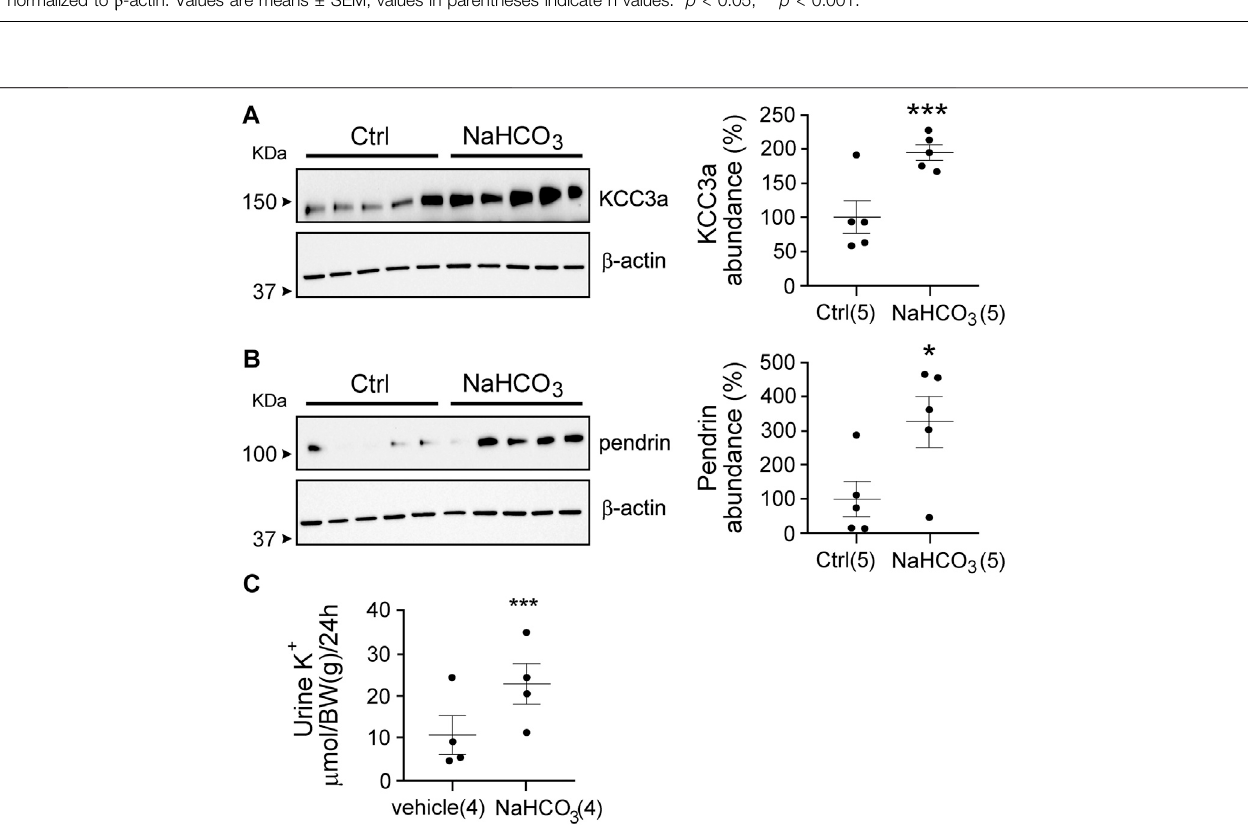
FIGURE7| LinkbetweenpendrinandKCC3a. (A,B) NaHCO 3 treatmentfor24 hincreasedKCC3aandpendrinabundancescomparedtocontrol(Ctrl),(two-tailed unpaired t -test). (C) Urinary K + excretion was higher in NaHCO 3 -induced alkalotic condition (two-tailed paired t -test). For blot quanti fi cation, densitometric values were normalized to β -actin. Values are means ± SEM; values in parentheses indicate n values. * p < 0.05; *** p < 0.001.